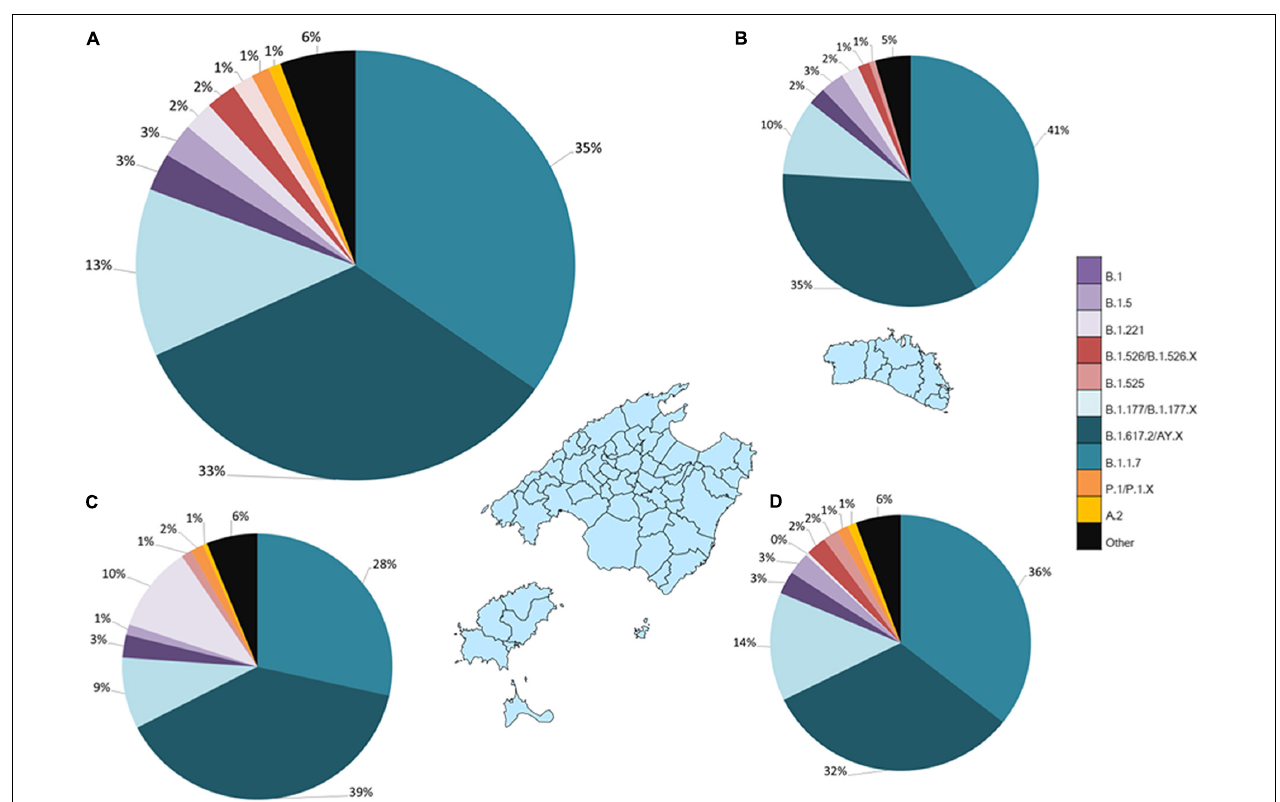
FIGURE 2 | Geographical distribution of the 10 most frequently detected PANGO lineages. Most frequent lineages detected in (A) the Balearic Islands, (B) Menorca, (C) Ibiza/Formentera, and (D) Majorca are shown.